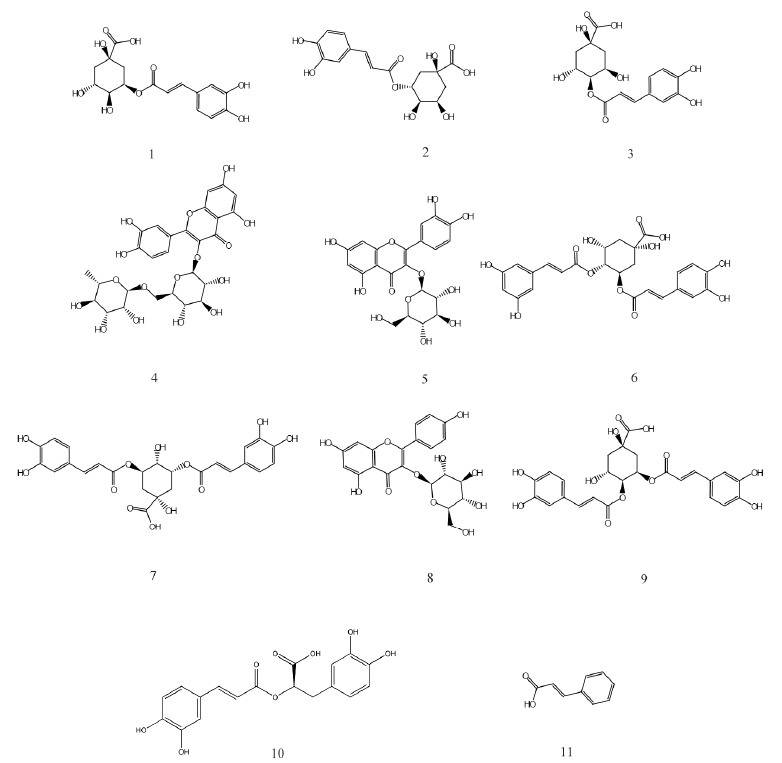
Figure 7. Chemical structures of 1–11 isolated from AVTE. 1: Neochlorogenic acid; 2: Chlorogenic acid; 3: Cryptochlorogenic acid; 4: Rutin; 5: Isoquercitrin; 6: Isochlorogenic acid B; 7: Isochlorogenic acid A; 8: Astragalin; 9: Isochlorogenic acid C; 10: Rosmarinic acid; 11: Trans-cinnamic acid.